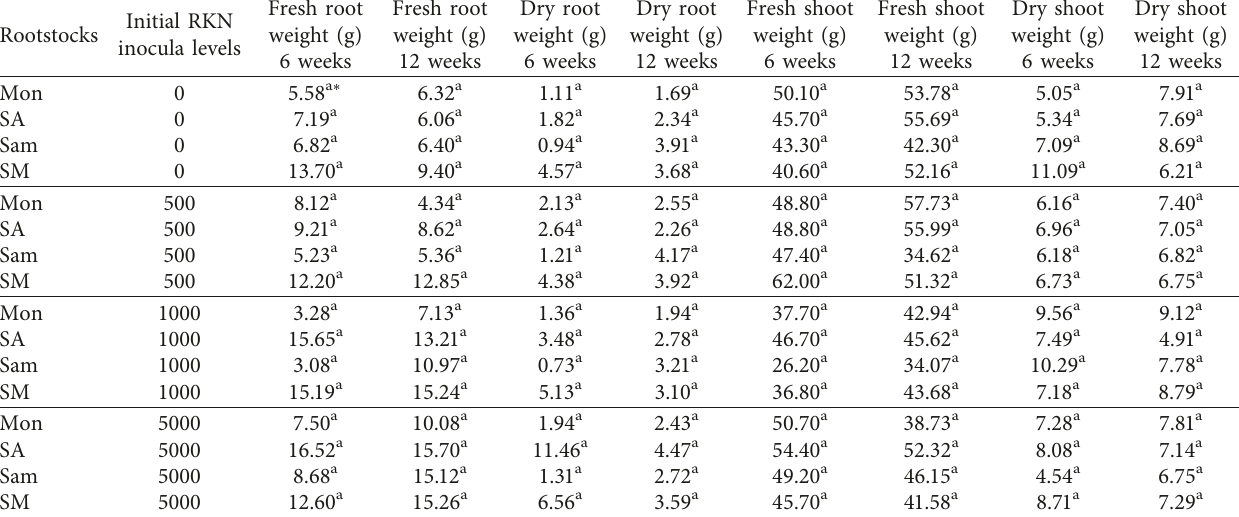
Table 3: Fresh and dry shoot and root weights in four rootstocks to three RKN inocula levels (0, 500, 1000, and 5000) 6 and 12 weeks after treatment application.